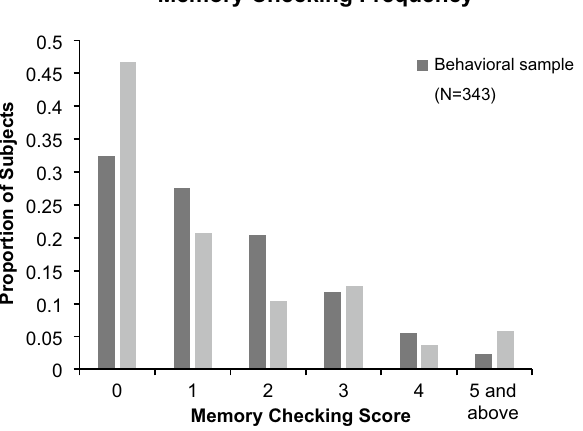
Figure 1. Proportion of participants reporting level of memory checking during and after the TNT trial in each of the samples; 0 = perfect compliance with the No-Think instructions as self-reported on the post-experiment compliance